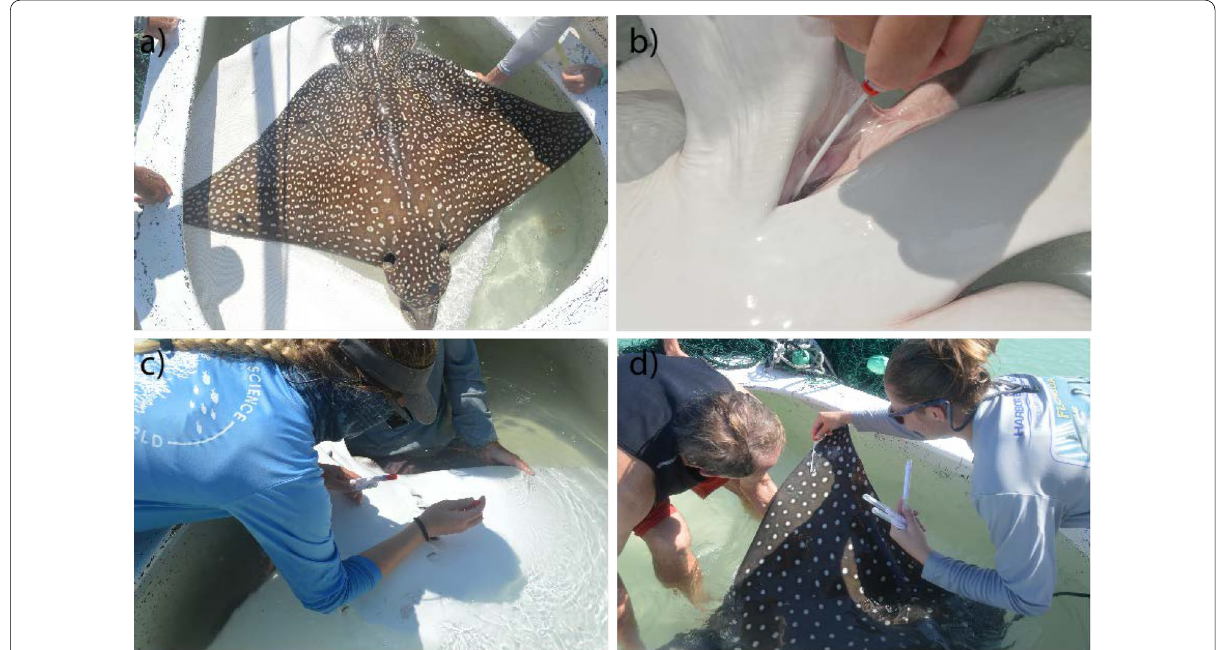
Fig. 1 Pictures demonstrating sample collection for wild whitespotted eagle rays ( Aetobatus narinari ): a a whitespotted eagle ray in holding tank after being brought onboard the boat, b cloaca sampling, c gill sampling, d skin sampling. All samples were collected by gently rubbing sterile swabs along the target body site